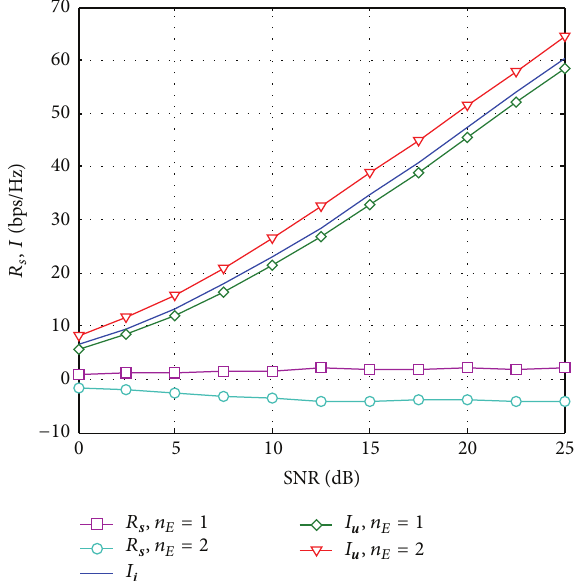
Figure 4: Mutual information and secrecy sum rate versus SNR for = 1 and 𝑛 = 2. The depicted values are the average over 5,000 𝑛 𝐸 𝐸 independent